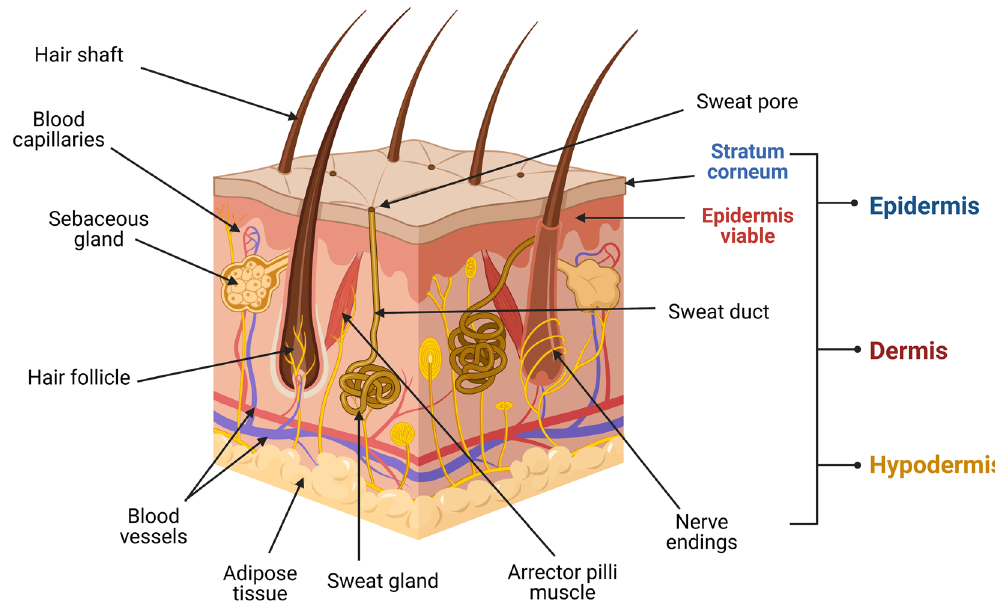
Figure 2: Human skin representation [ 27 ] ( created with BioRender.com )